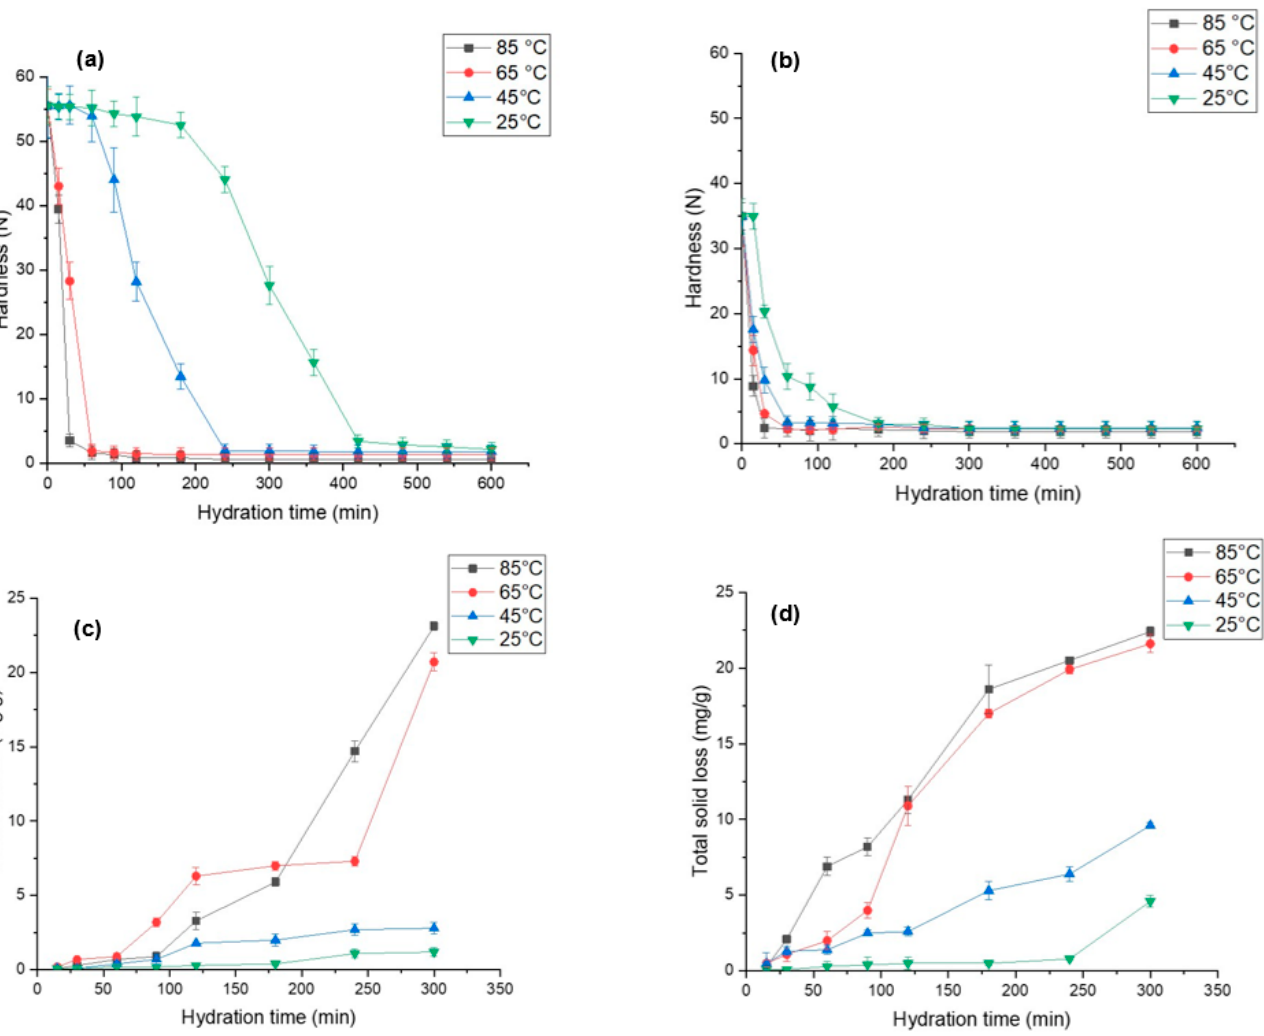
Figure 4. Changes in hardness and total solid loss for ( a , c ) L. albus and ( b , d ) L. angustifolius during hydration at different